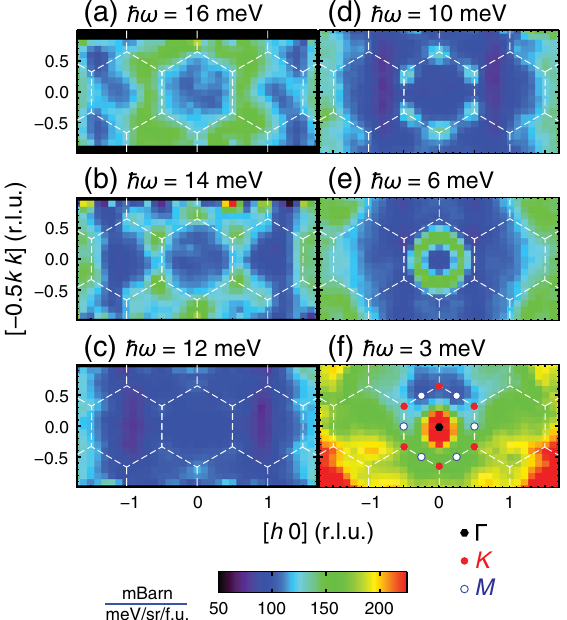
FIG. 2. Constant- ℏ ω cuts of spin waves at selected energy- transfer values within the ð h; k Þ plane at 5 K. In all plots, data were subtracted by the empty-can background, integrated over the energy range of ℏ ω (cid:3) 0 . 5 meV as well as integrating over − 5 ≤ l ≤ 5 . The dashed lines are the BZ boundaries of the 2D reciprocal lattice. In (f), the Γ , K , and M points are marked along the first BZ boundary for